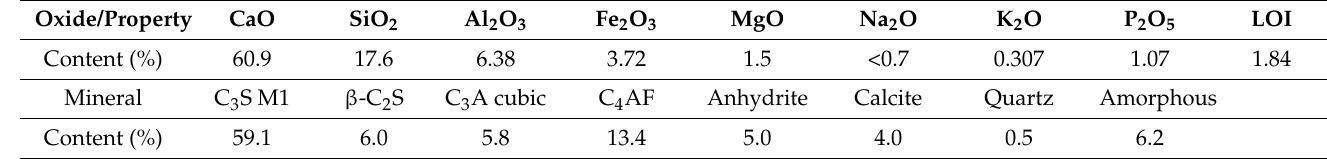
Table 3. The oxide and mineral composition of Portland